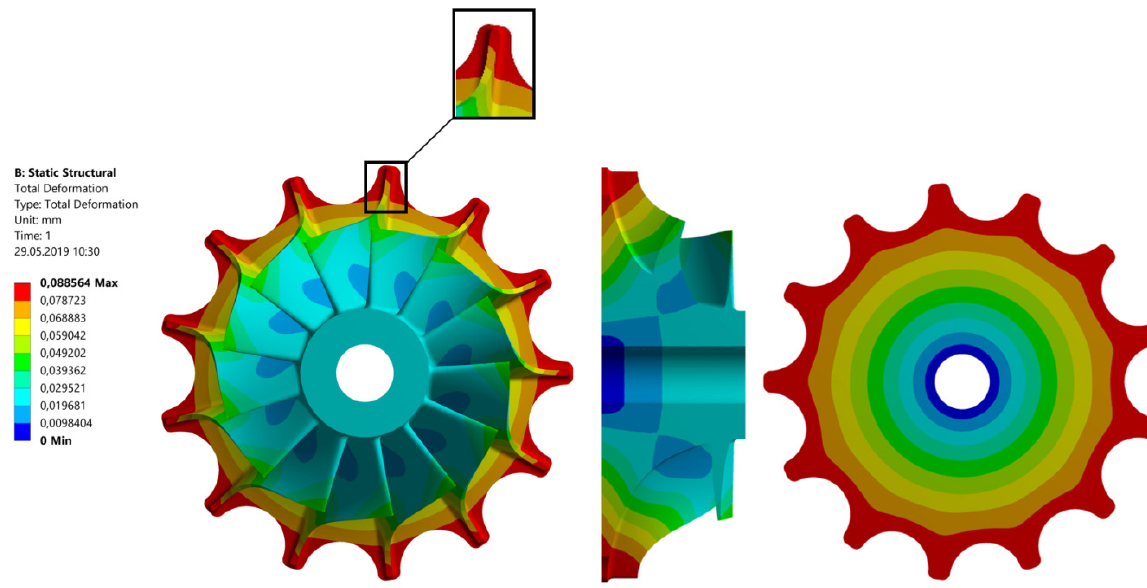
Figure 17: Deformation distribution of turbine disc - optimisation 1 (rotational speed – 96,000 rpm; temperature – 600 ∘ C)